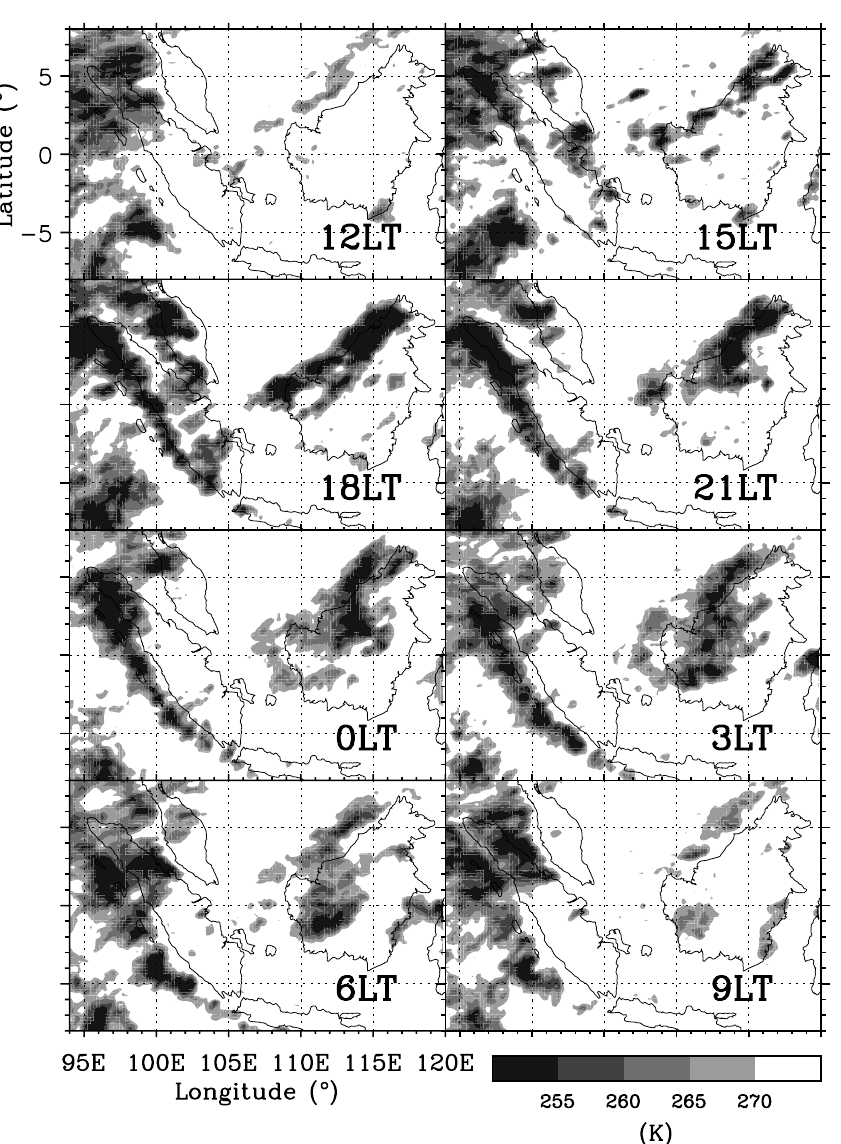
Fig. 16. Longitude-latitude plots of T BB averaged at 00:00, 03:00, 06:00, 09:00, 12:00, 15:00, 18:00 and 21:00 LT during Period 1 (1–9